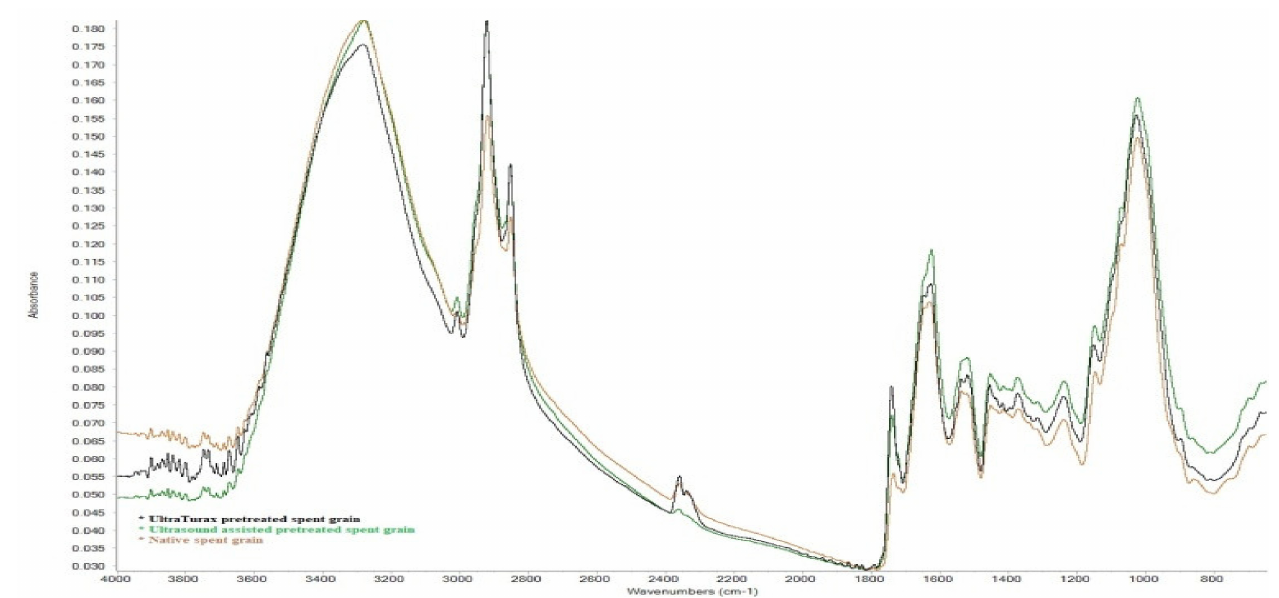
Figure 5. FTIR spectra of native SG and SG